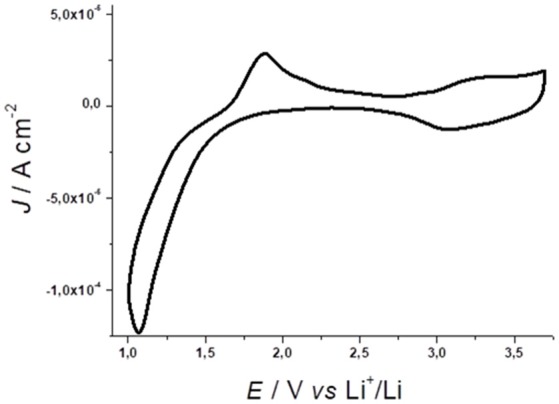
Cyclic voltammetry of NiO prepared via conventional sintering of sprayed NiO nanoparticles (average diameter, ø: 50 nm). Electrolyte composition: 0.7M LiClO4 in anhydrous propylene carbonate; counter electrode: Li; reference electrode: Li+/Li; scan rate: 15mV s−1. NiO thickness: 0.3 μm. Adapted from Awais et al. (2013b).